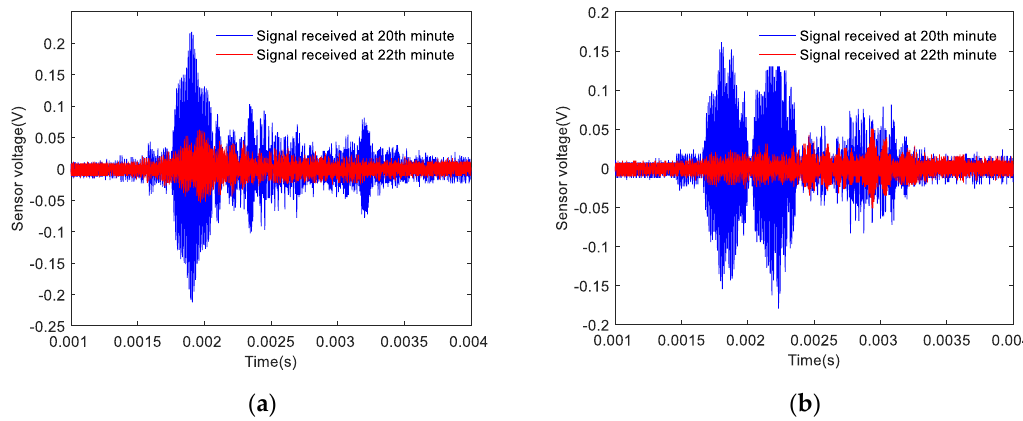
Figure 16. Time-domain signal of Composite specimen I before and after damage: ( a ) Measured signal by SA 3; ( b ) Measured signal by SA 4.